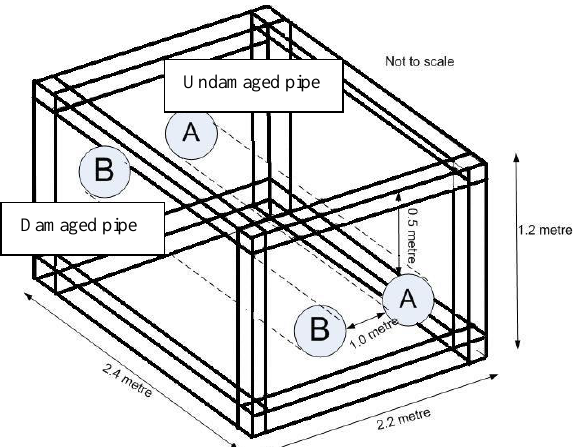
Figure 4: A schematic model of the test facility indicating the pipe position